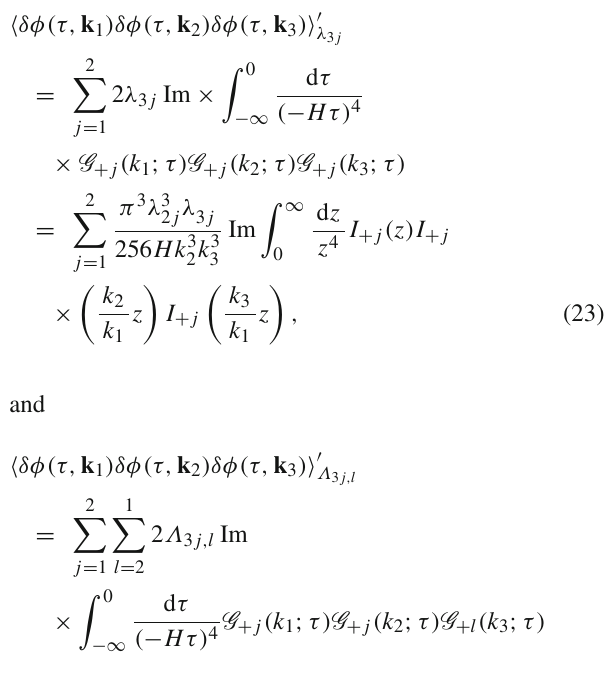
ence between QSMF model and quasi-single field,